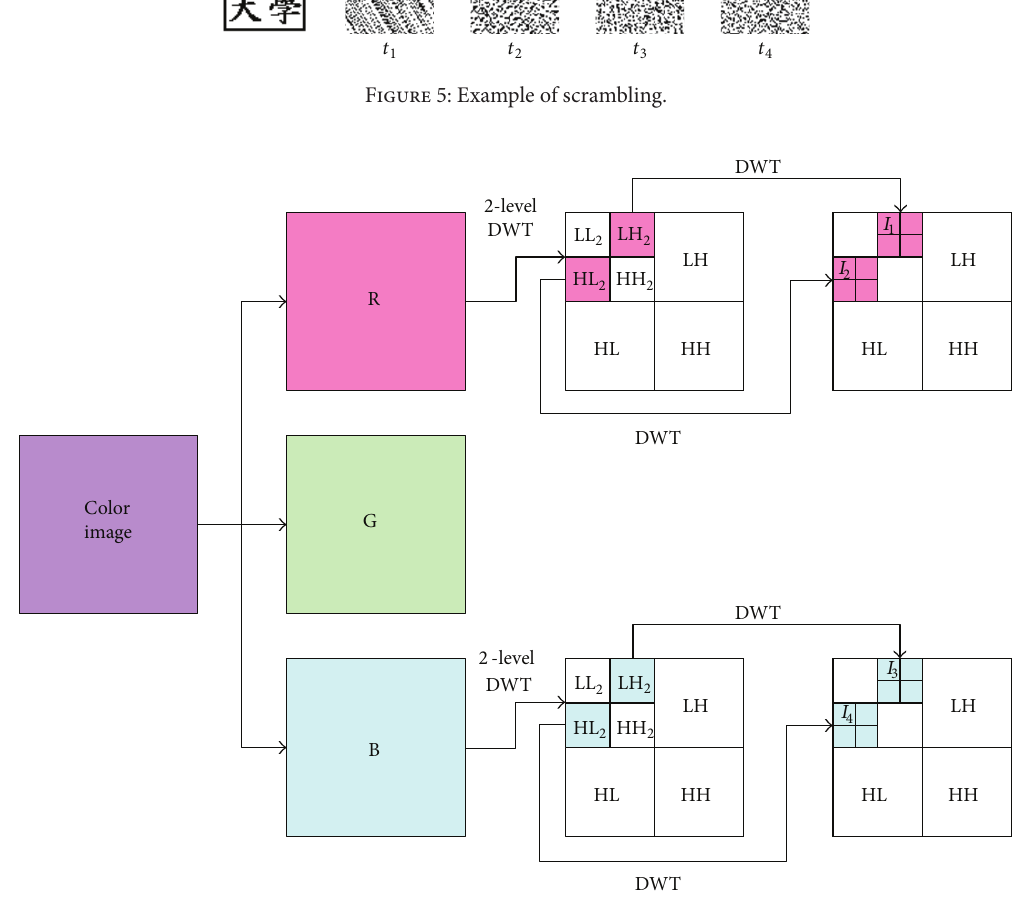
Figure 6: The 𝐼 1 , 𝐼 2 , 𝐼 3 , and 𝐼 4 blocks used for watermark embedding